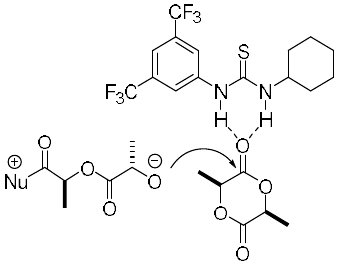
Figure 1. Activation of L -lactide monomer by a thiourea additive.